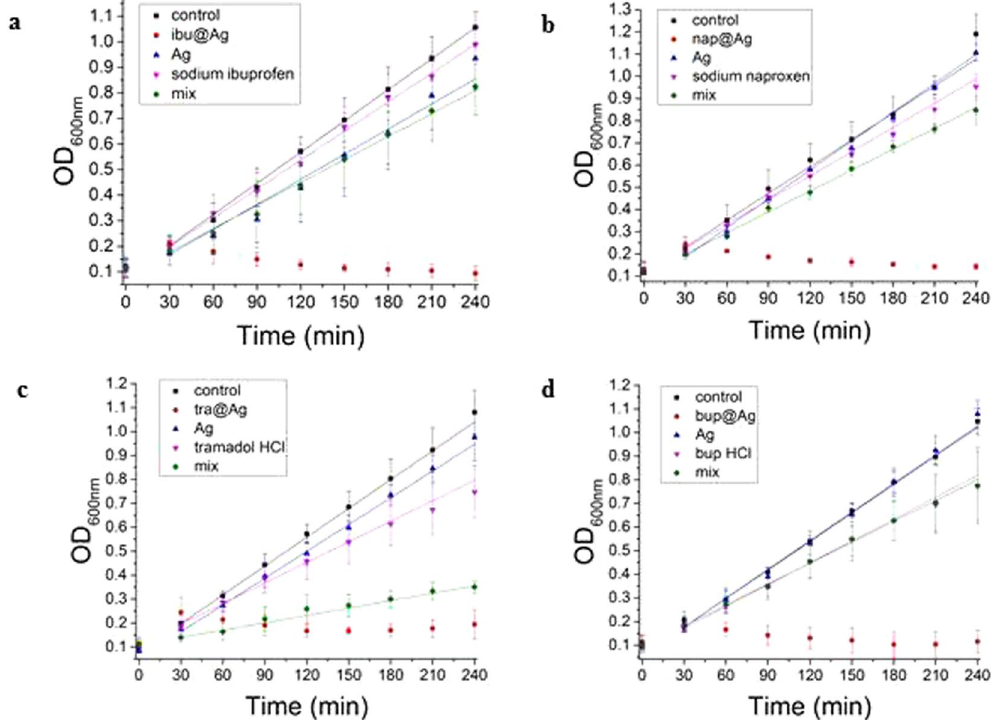
Figure 5. Bacterial ( P. aeruginosa PAO1) growth as a function of time: ( a ) ibu@Ag, ( b ) nap@Ag, ( c ) tra@ Ag, ( d ) bup@Ag. Total inhibition by the drug-silver composites: red dots at the bottom. This total inhibition is compared to several blanks, all at concentrations and amounts that follow the composites: Control (uninterrupted growth) – black; metallic silver prepared by the same method but without the dopant – blue triangles; the pure drug – down-pointing pink triangles; solution mixture of metallic Ag and the dissolved drug – green diamond. Zero point: before addition of the agents. 0.1 OD unit = 10 8